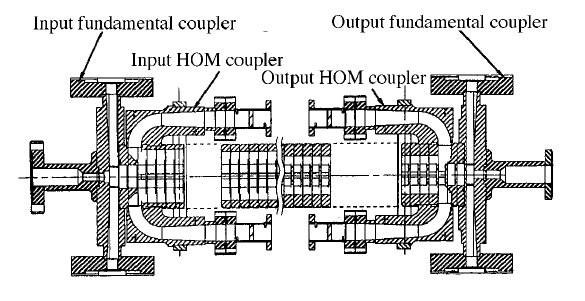
FIG. 1. Cross section of the DDS-3